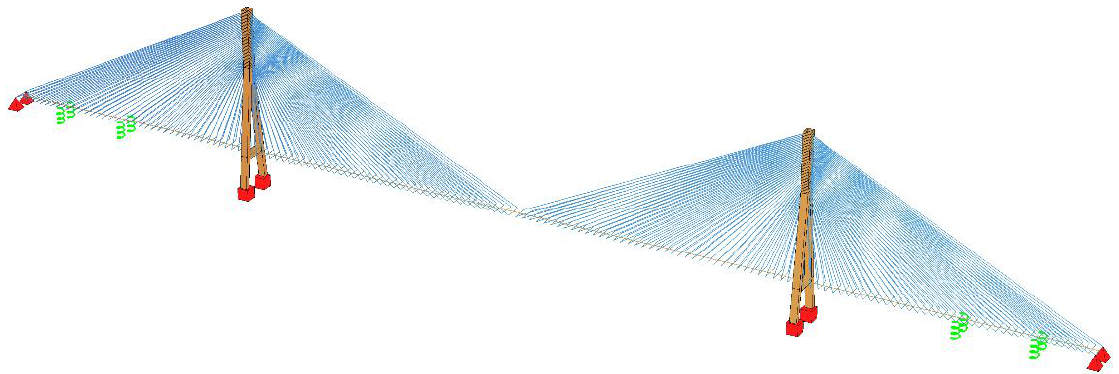
Figure 4. Finite element model of the investigated cable-stayed bridge (main span = 1200 m).